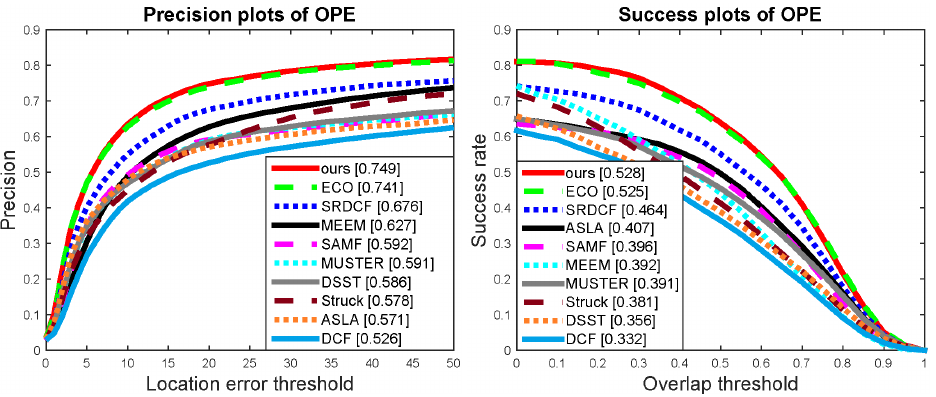
Figure 10. Precision plot and success plot on the UAV123 dataset. The AUV score and precision score of each tracker is shown in the legend. For clarity, we only show the top 10 trackers for performance.